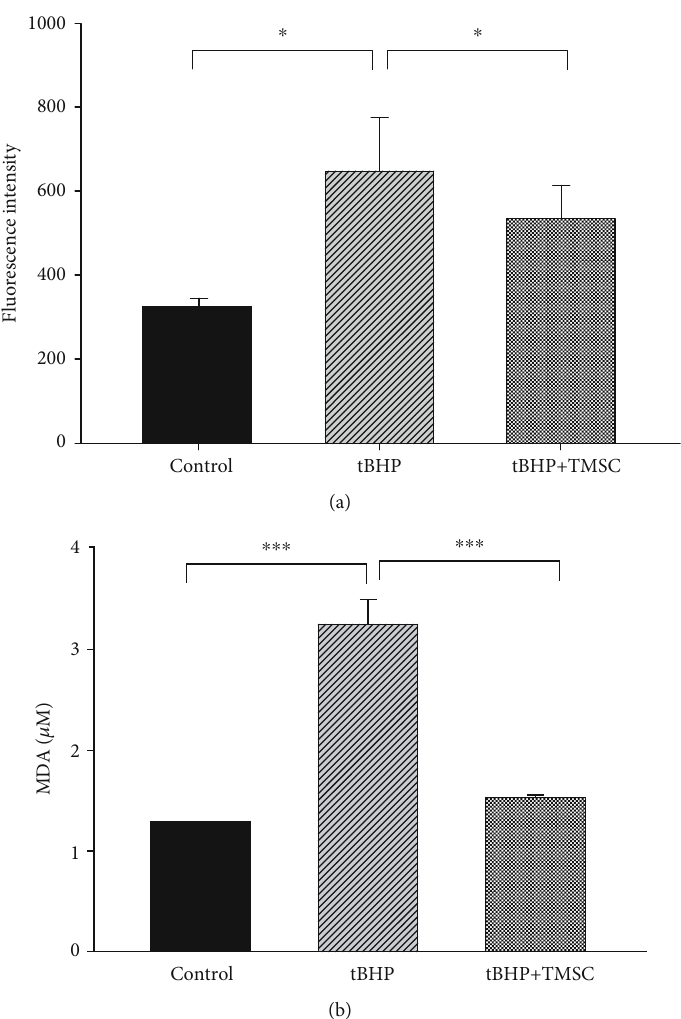
Figure 2: Analysis of ROS production and expression of MDA following treatment with tBHP. (a) The fl uorescence intensity in the DCFDA array increased following treatment of hVFFs with tBHP. After coculturing with TMSC, tBHP-treated hVFFs exhibited signi fi cantly decreased fl uorescence intensity levels. (b) MDA was signi fi cantly increased in tBHP-treated hVFFs, while coculture with TMSCs signi fi cantly decreased MDA levels. Results are 3 technical replicates of TMSC from one donor. Representative results from two di ff erent TMSCs with similar tendency were presented. For multigroup comparison, ANOVA followed by the Bonferroni post hoc test was used for statistics. Results are shown as the mean ± SD . ∗ P < 0 : 05 , ∗∗∗ P < 0 : 001